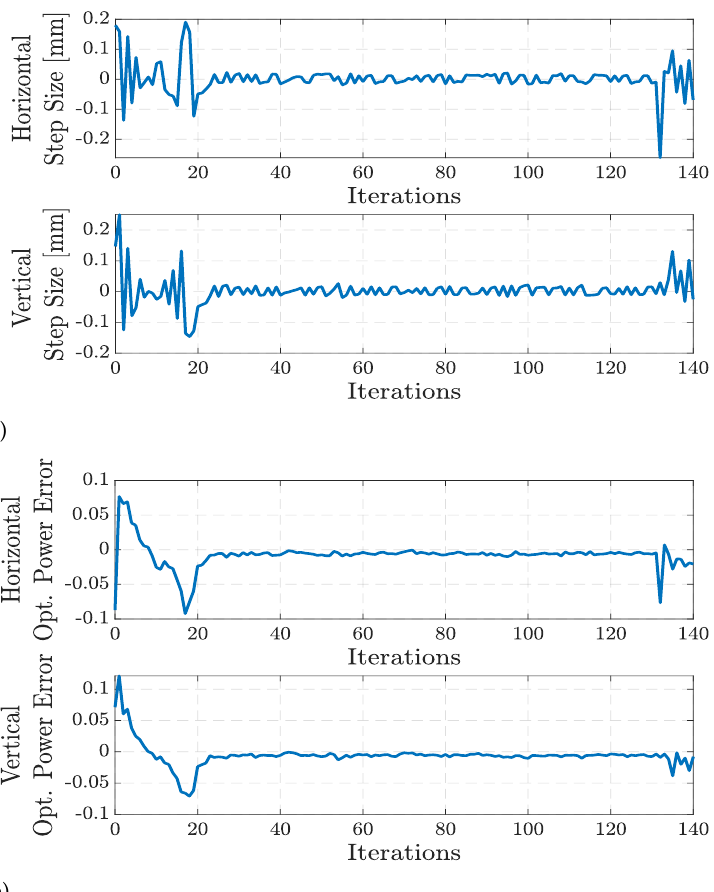
Figure 12. ( a ) Registered motors’ step size during the 2nd-stage displacement. ( b ) Measured algo- rithm error during the 2nd-stage